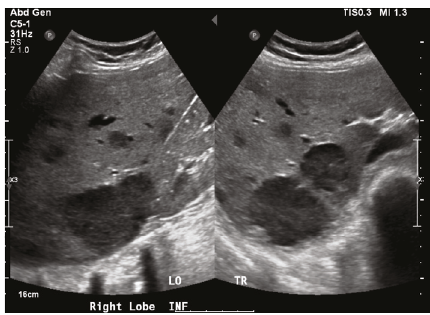
Figure 1: Right lobe liver ultrasound (inferior view) showing innumerable hypoechoic heterogeneous masses, the largest of which was located inferiorly and measured 6.0 × 4.3 × 5.4 cm.